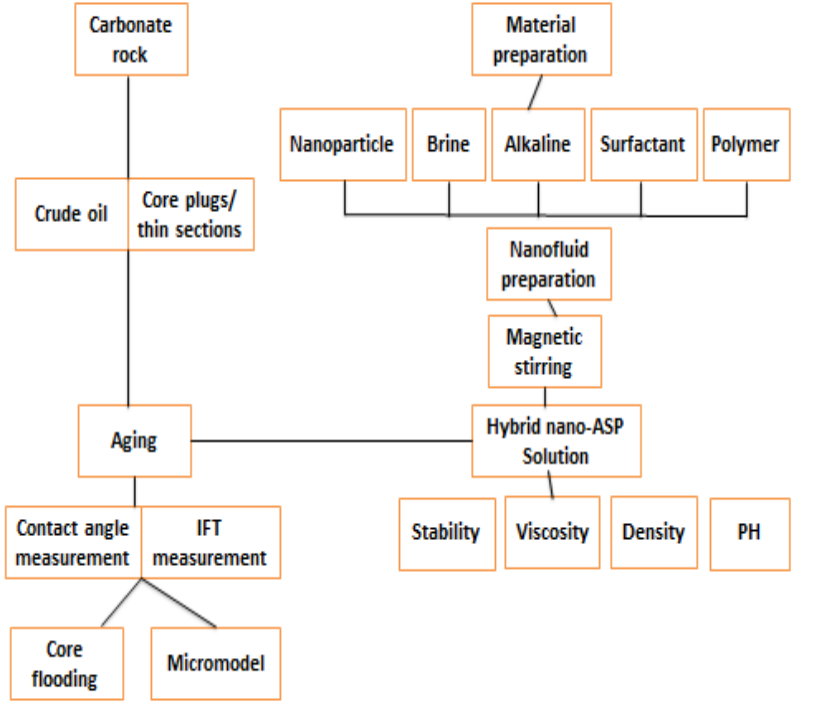
Figure 8. Future experimental work. The figure forecasted NASP experimental work methodology. The latter is subdivided into several sections: material preparation, carbonate rock preparation and EOR static tests (IFT and contact angle) and Dunamis tests (core flooding and micromodel).